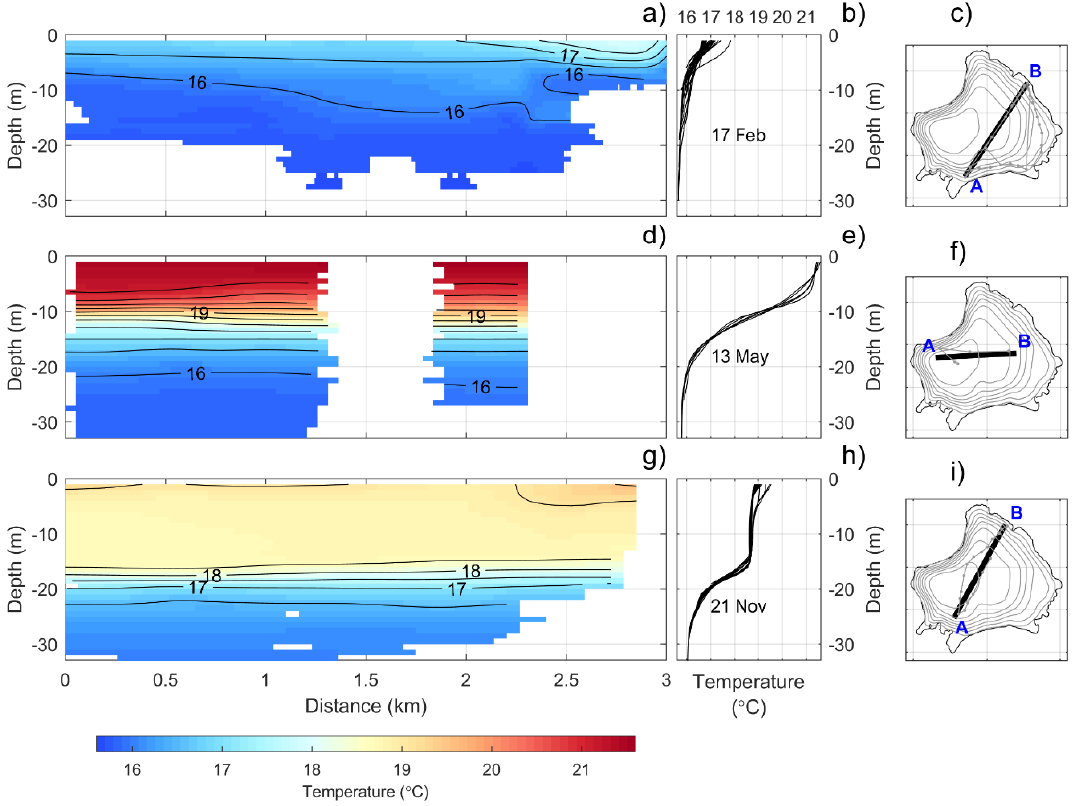
Figure 10. Transects of CTD data obtained on ( a ) 17 February, ( d ) 13 May, and ( g ) 21 November. The CTD profiles ( b , e , h ) were interpolated with an objective mapping technique into a transect ( a , d , g ) to obtain the spatial variability of the temperature with depth and across the lake, as indicated in the map from A – B ( c , f , i ). The contour lines are at 0.5 °C intervals, and only two of them are labeled.